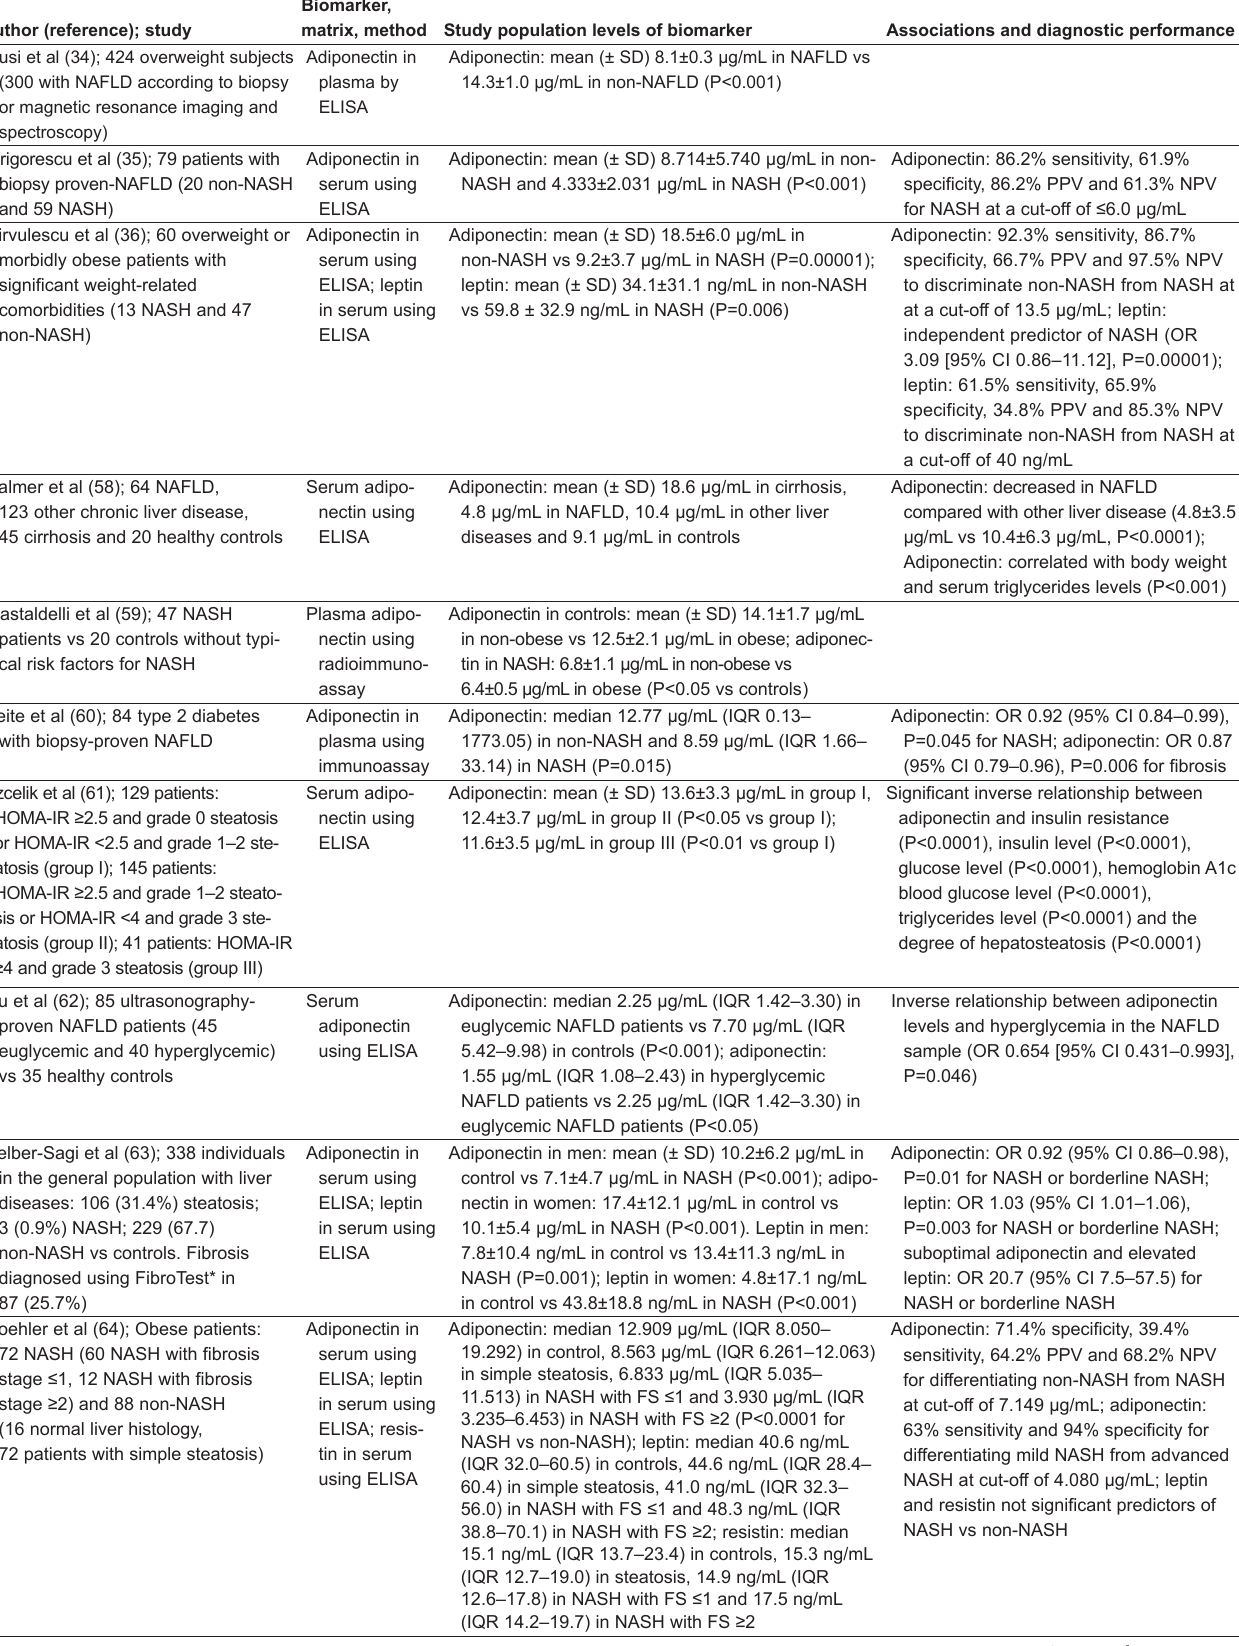
TAbLe 2 Studies investigating adiponectin, leptin, resistin and retinol binding protein 4 in NAFLD